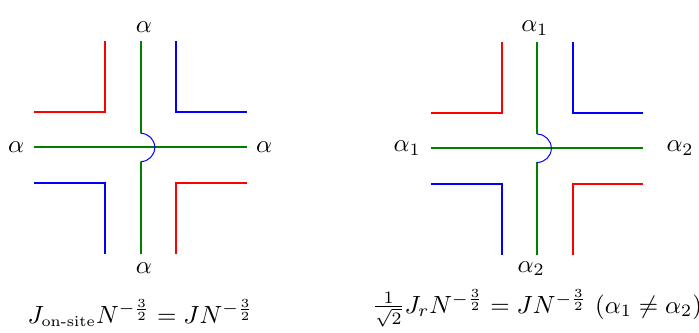
Figure 3. The Vertices of the on-site and (non-local) hopping